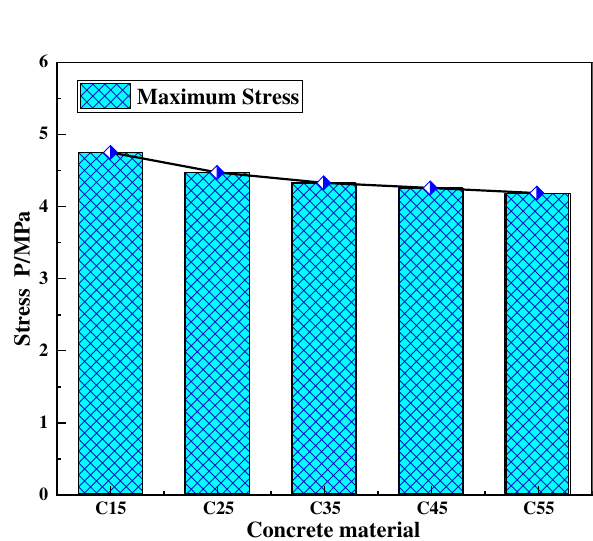
Figure 7. Displacement curve of foundation node under different concrete grades.